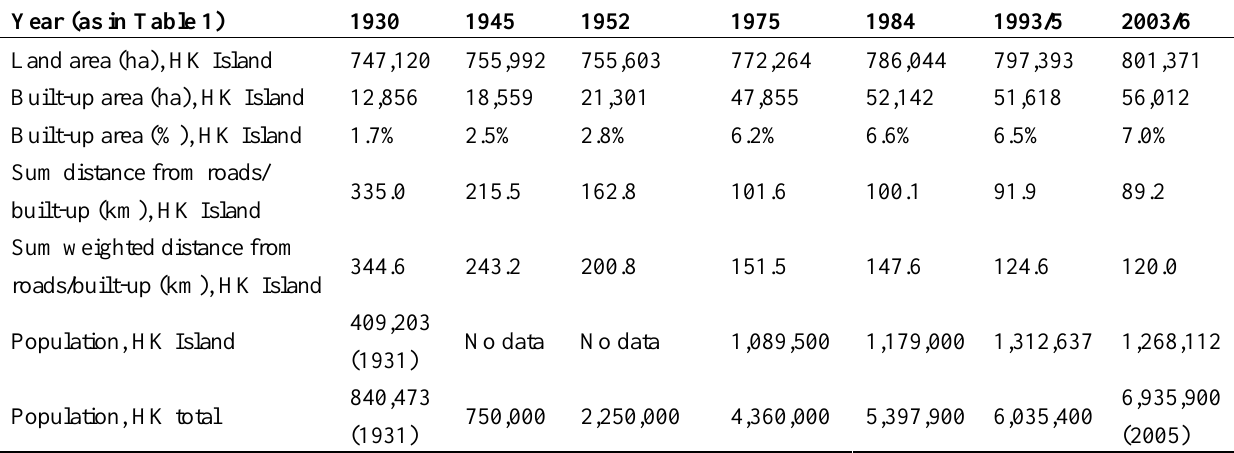
Table 3. Time series of selected variables analyzed in this